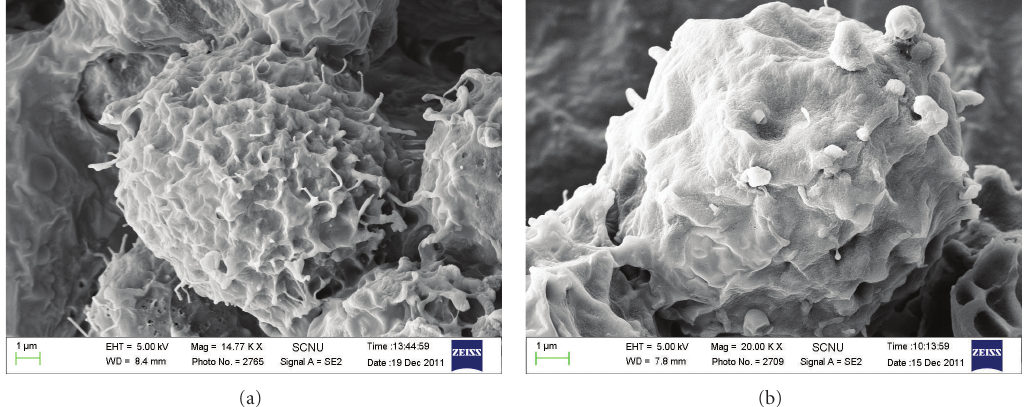
Figure 7: The ultrastructural morphology of the cultured HL60 cells before and after light therapy. (a) The control cells. (b) The treated cells.